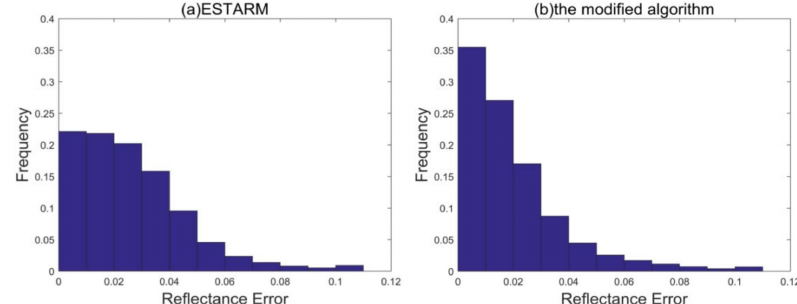
Figure 8. Frequency statistics histogram of the R mean absolute di ff erence of results predicted by ESTARFM ( a ) and the modified algorithm ( b ) in